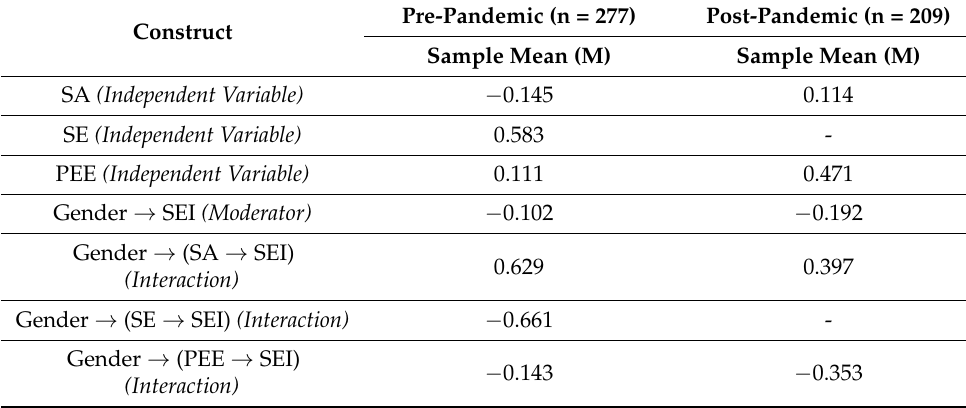
Table 10. Sample mean